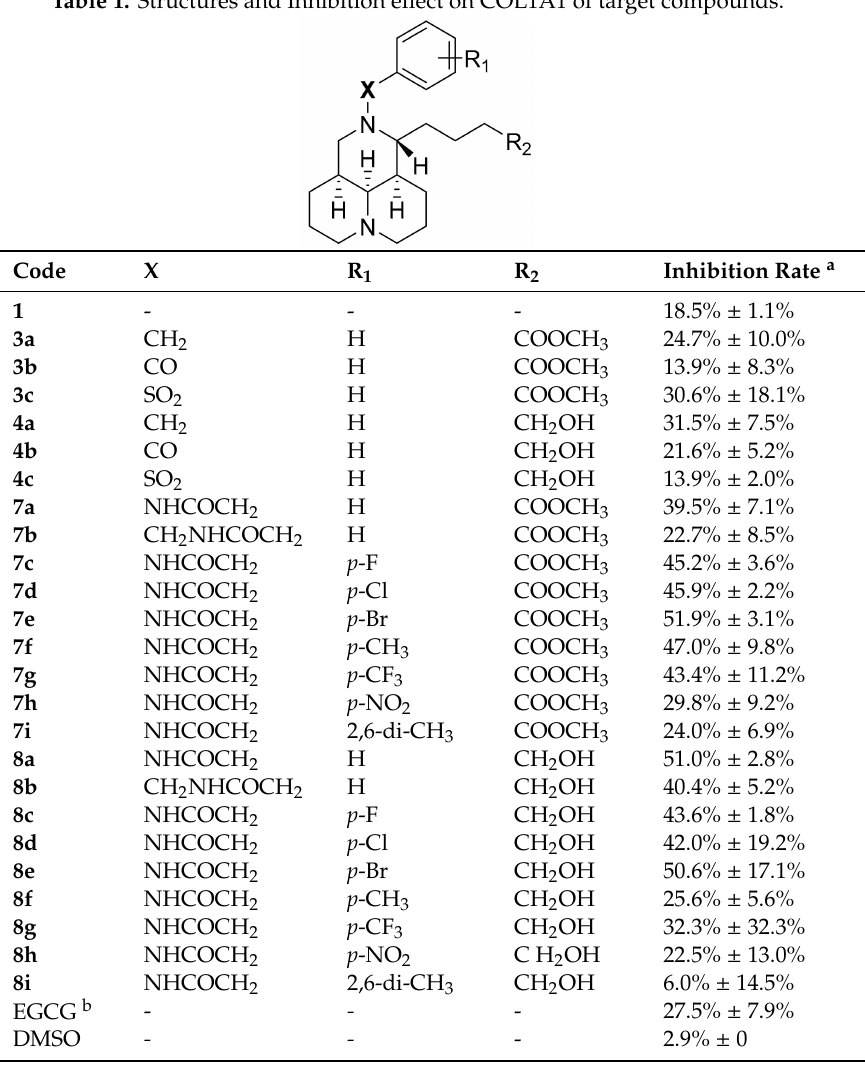
Table 1. Structures and Inhibition e ff ect on COL1A1 of target